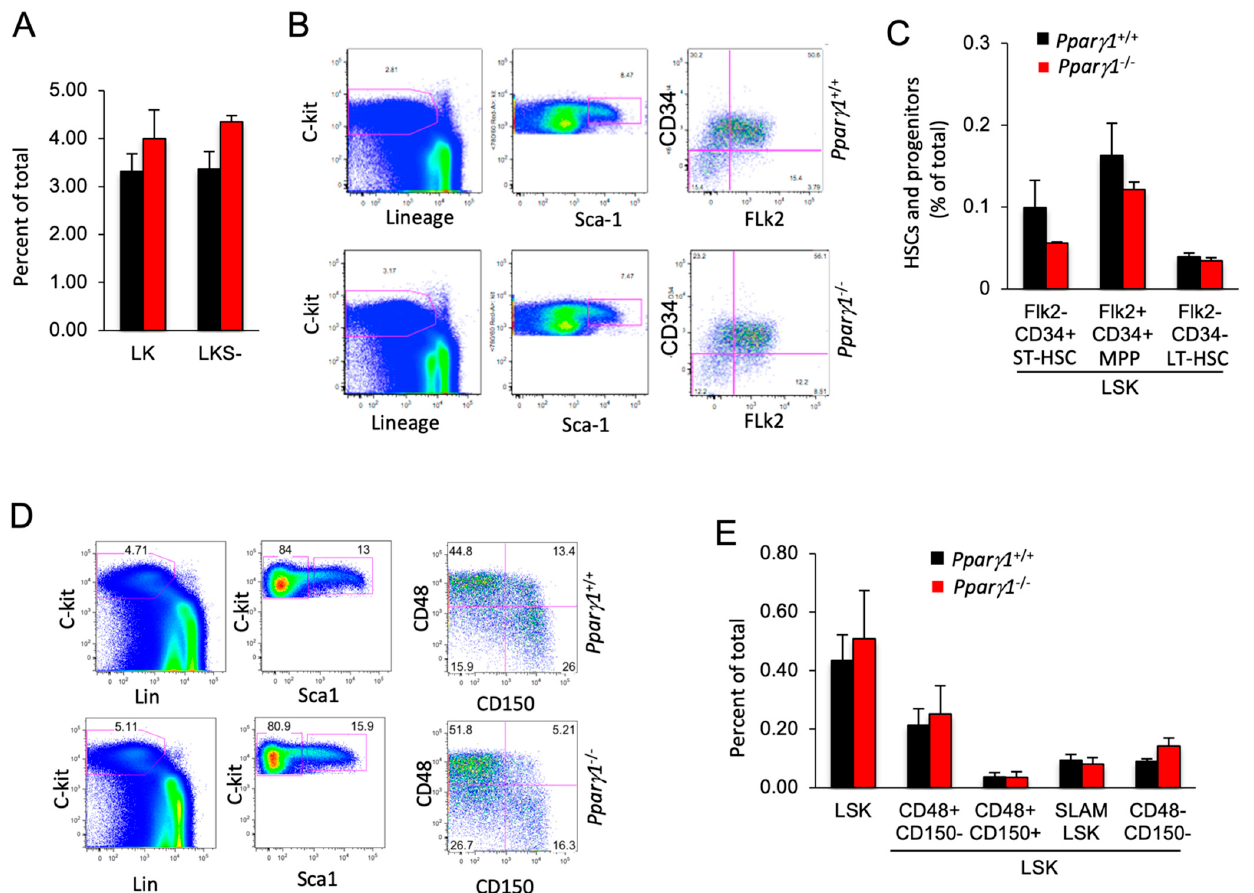
Figure 5. Hematopoietic stem cell (HSC) distribution of LT-HSC and ST-HSC is unchanged in Ppar γ 1 +/+ vs. Ppar γ 1 − / − multigenic mice. ( A ). the LK and LKS − are shown as a percent of total as mean ± SEM. ( B ). Relative distribution of HSC lineage components, using c-Kit, Sca-1 and Flk2 shown as representative FACS analysis. ( C ). HSC lineage proportion of LSK cells shown for proportion of Flk2/CD34 as mean ± SEM. ( D ). Representative FACS plots for the HSC and progenitor markers with antibodies to c-Kit, Lin, Sca-1, CD48/CD150. ( E ). Relative distribution of LT-HSC lineage components (LSK/CD48/CD150) shown as mean ± SEM for n = 10 total.